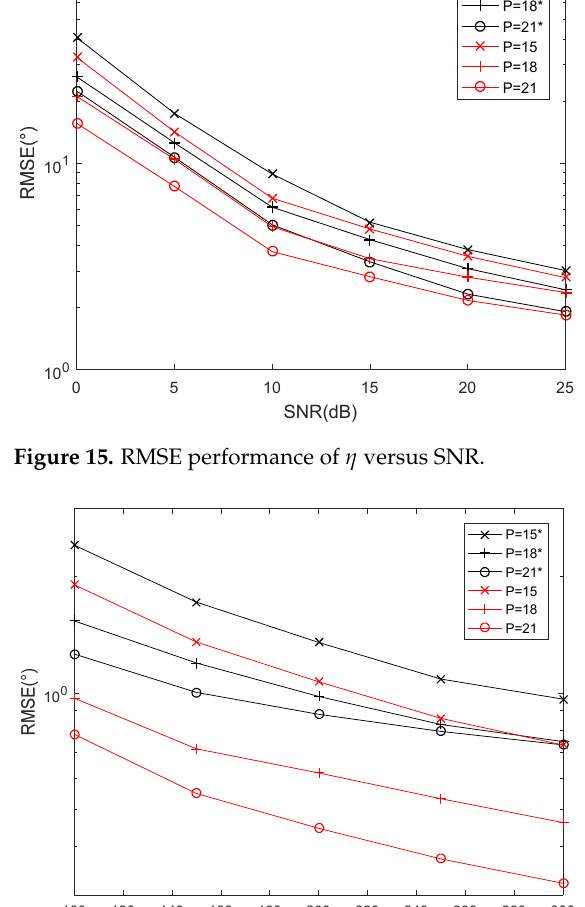
Figure 16. RMSE performance of